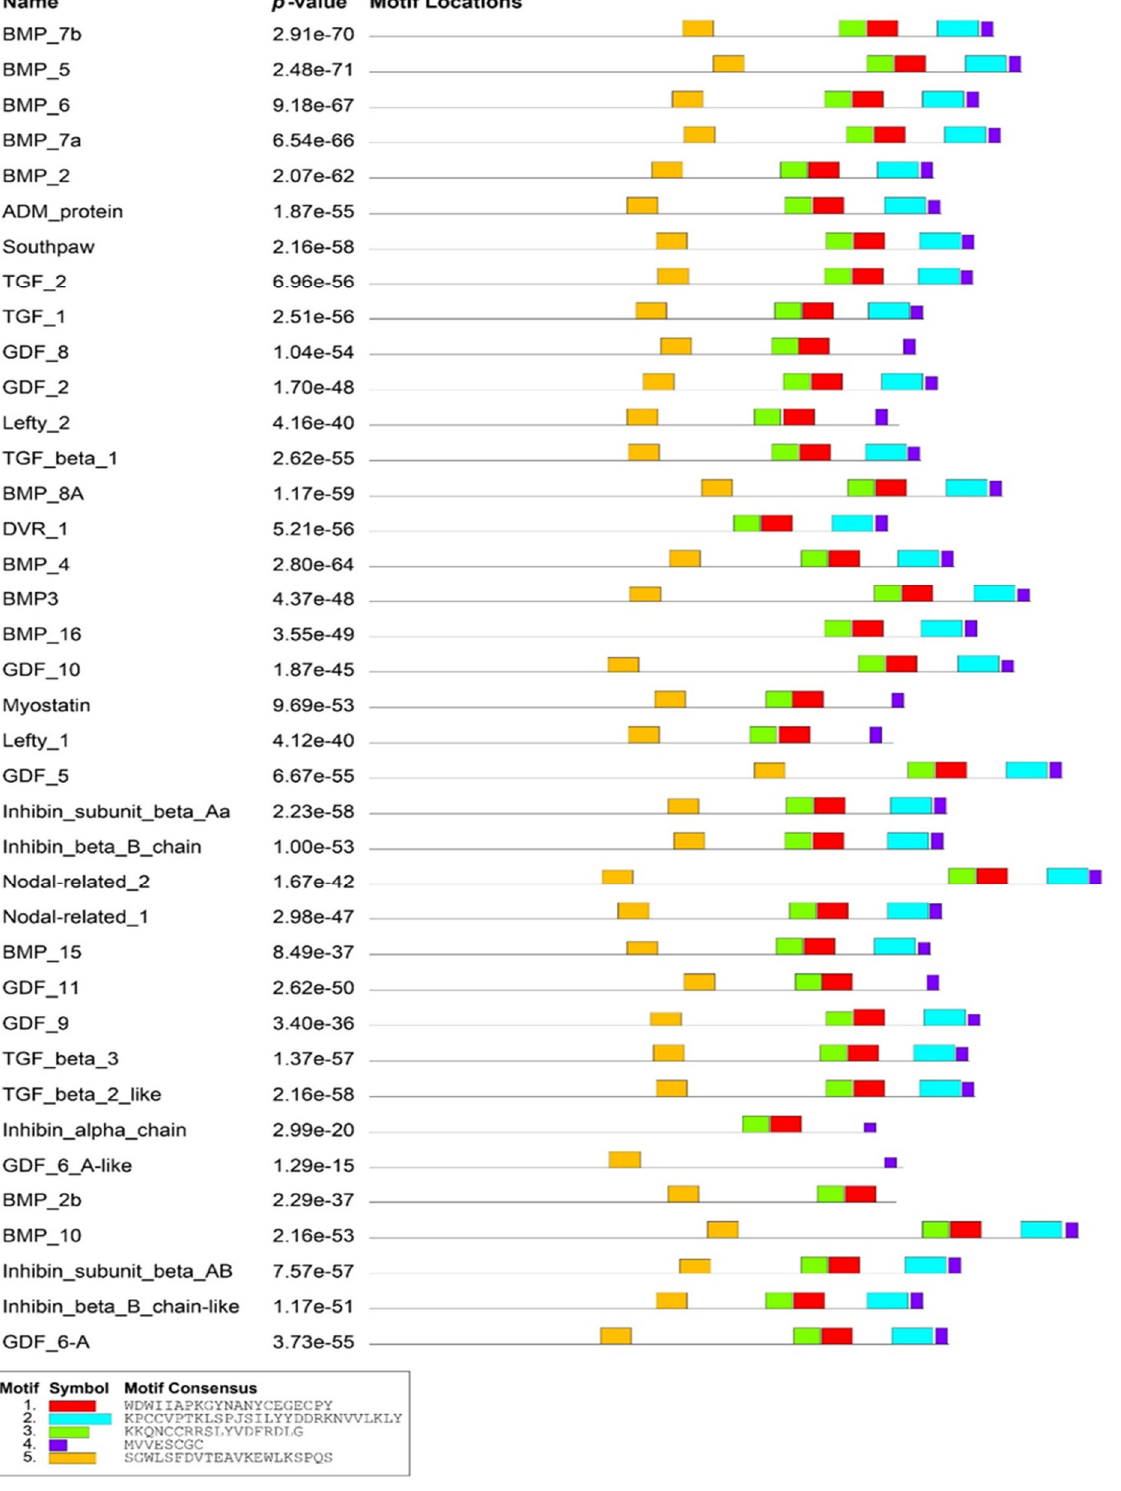
Figure 1. Domain organisation of 38 BMP family members. Five consensus sequences of TGF motifs were identified in these proteins. Red, cyan, and green boxes indicate TGF beta peptide domains. Yellow box indicates TGF beta pro peptide domain. TGF = Transforming growth factor.